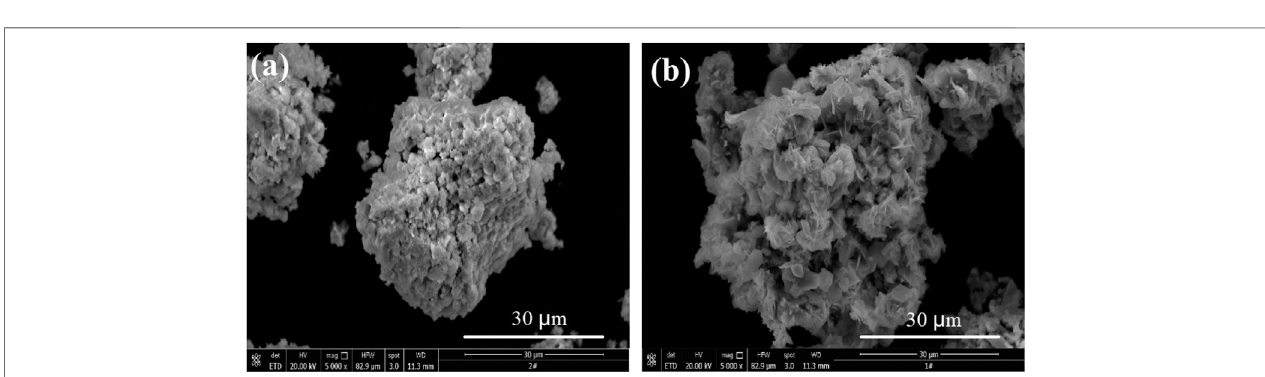
FIGURE 10 | SEM micrograph of the sample and sulfuric acid transition